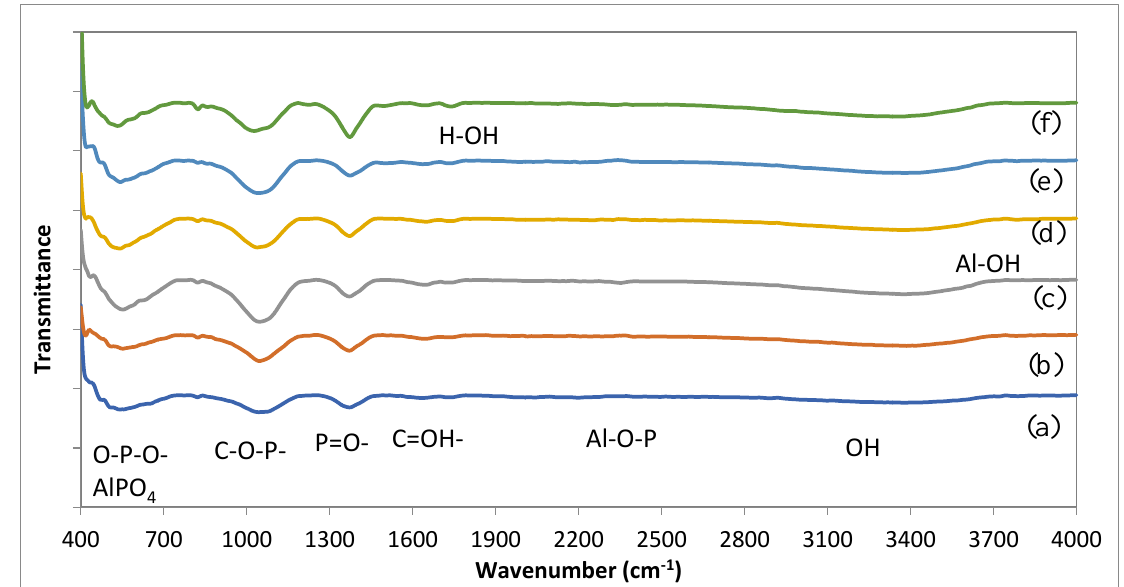
Figure 5. FTIR spectra for as prepared PPVA-AlPO 4 nanocomposite samples at different pH values ( a ) 7; ( b ) 8; ( c ) 9; ( d ) 10; ( e ) 11; ( f ) 12.